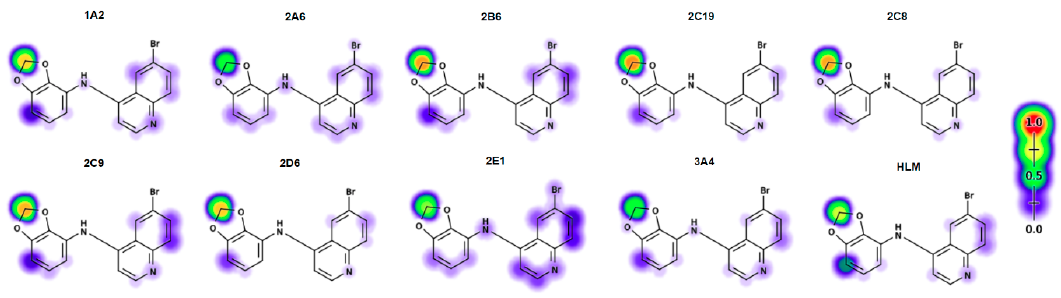
Figure 9. Compound 8 in XenoSite’s P450 Metabolism P450 1.0 algorithm.